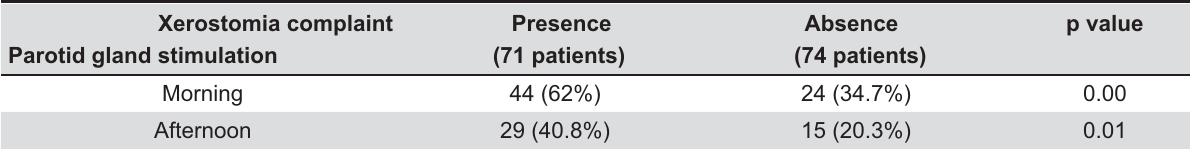
Table 4- Relation between xerostomia complaint and total number of patients without salivary secretion during parotid glands